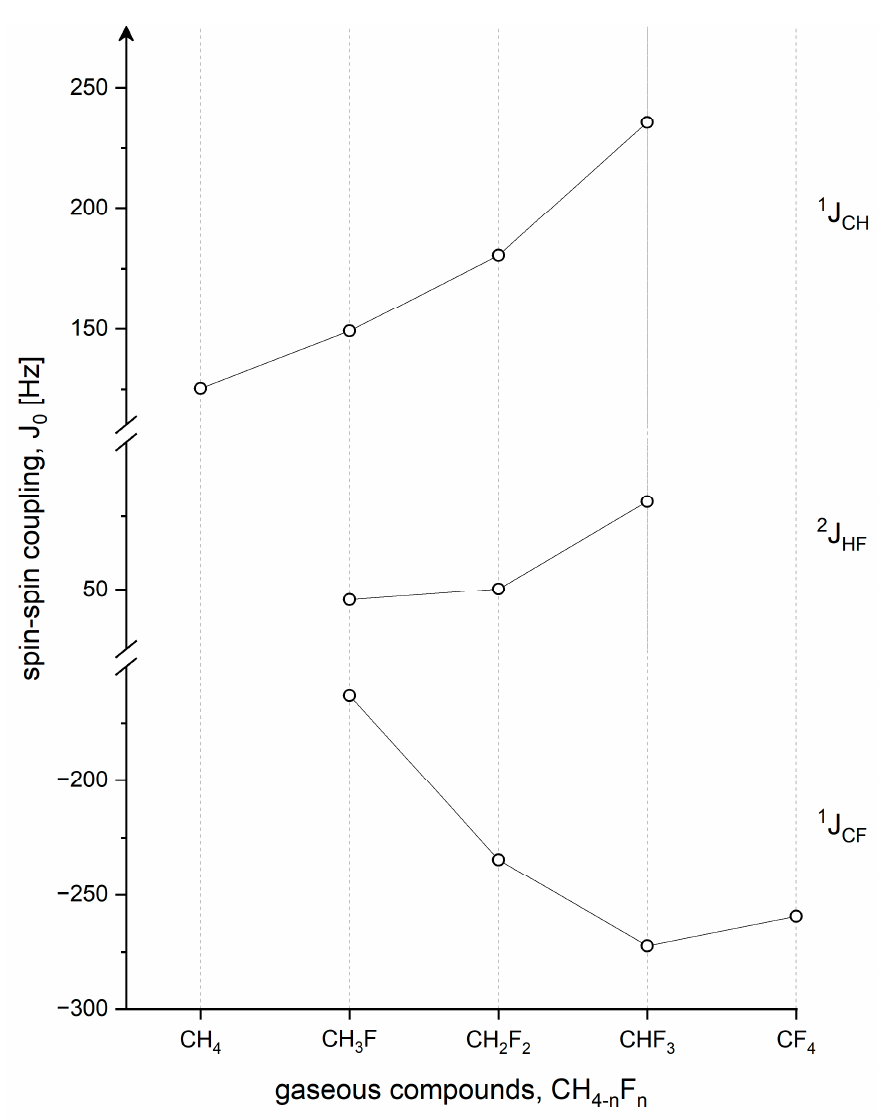
Figure 3. Spin-spin couplings of fluoromethanes without the influence of intermolecular interactions as seen in 19 F, 13 C, and 1 H NMR measurements. The opposite signs of 1 J CH and 1 J CF coupling constants were first found in double-resonance experiments [104].